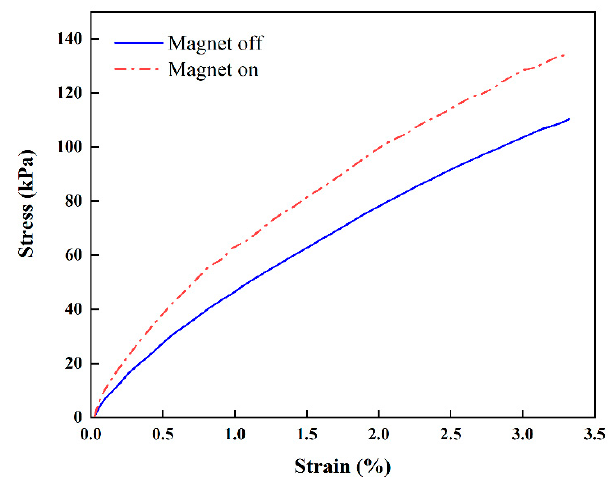
Figure 10. Stiffness variation of specimen 2 (top–bottom PM configuration, Figure 6d). 4. Concluding Remarks In this study, a new flexible beam structure with a tunable stiffness was fabricated by 3D printing. Its field-dependent stiffness was experimentally validated. To tune the stiffness, the MRF was embedded in the 12 channels (specimen 1) and three channels (specimen 2) in the skin of the TPU. The stiffness of specimen 1 could be increased by approximately 22.9% and 13.9% by applying a magnetic field to the MRF domain by using PMs attached on the top and bottom for 1 mm and 2 mm strokes, respectively. By changing the position of PMs, the stiffness increment can be altered. Therefore, the optimal locations of PMs need to be determined to maximize the stiffness increment. In the test of specimen 1, the stress–strain results showed that the stress of 110.74 kPa without the magnetic field was increased to 135.82 kPa by PMs attached at both sides of the specimen. On the other hand, in specimen 2, the average stiffness increment ratios from the origin to the strokes of 1 and 2 mm were identified as approximately 39.78% and 23.10% upon the application of the magnetic